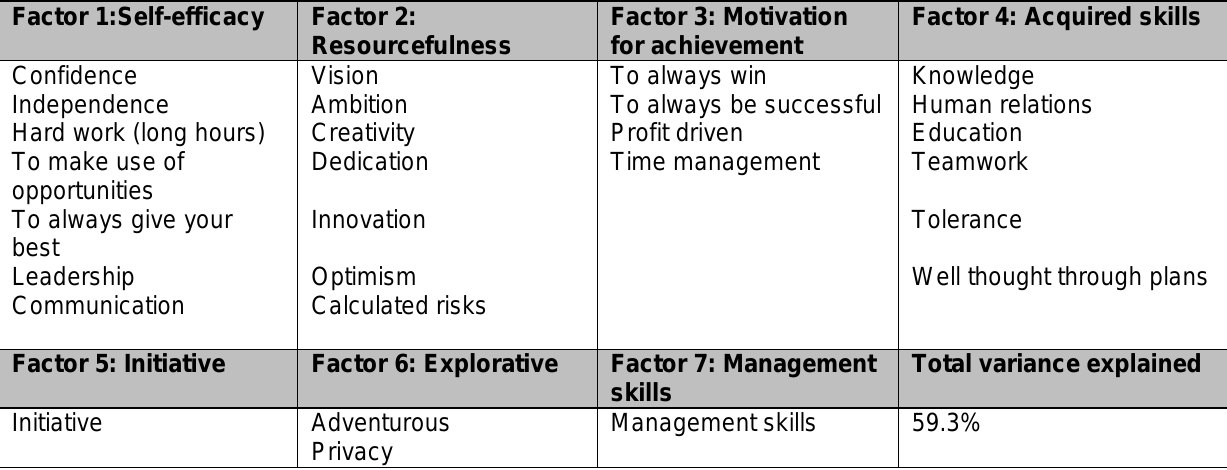
Table 3: Factor analysis results of entrepreneurial attributes at the GNAF Factor 1:Self-efficacy Factor 2: Factor 3: Motivation Factor 4: Acquired skills Resourcefulness for achievement Confidence Vision To always win Knowledge Independence Ambition To always be successful Human relations Hard work (long hours) Creativity Profit driven Education Dedication Time management Teamwork Innovation Tolerance Leadership Optimism Well thought through plans Communication Calculated risks Factor 5: Initiative Factor 6: Explorative Factor 7: Management Total variance explained skills Initiative Adventurous Management skills 59.3%